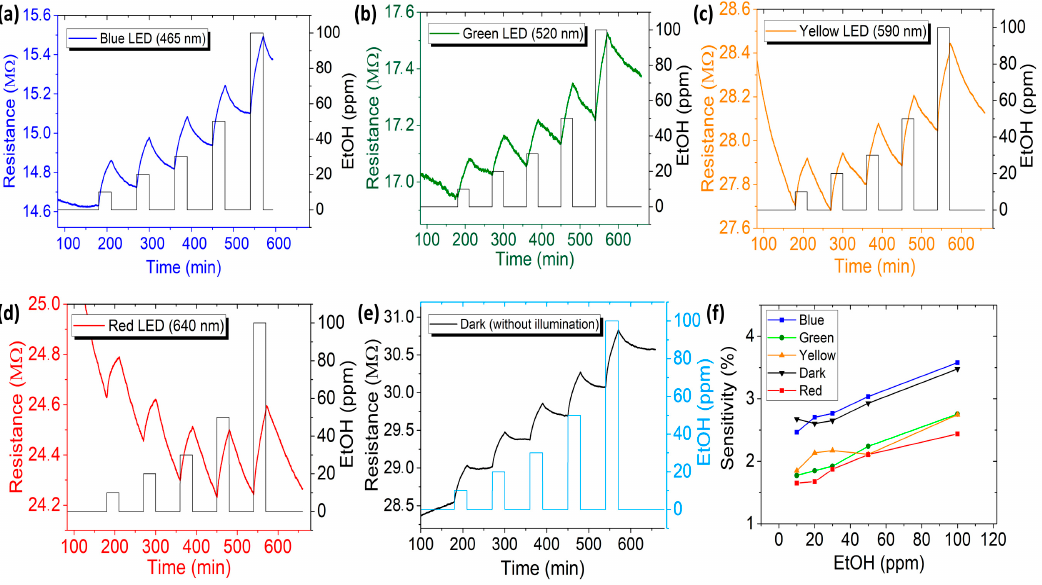
Figure 4. Dynamic responses of CaFe 2 O 4 in varied vapor concentrations (i.e., 10, 20, 30, 50, and 100 ppm) of ethanol under activation of ( a ) blue (465 nm), ( b ) green (520 nm), ( c ) yellow (590 nm), ( d ) red (640 nm) LEDs and ( e ) dark condition (without illumination). ( f ) Comparison of the sensor sensitivity under visible light exposures and dark condition.